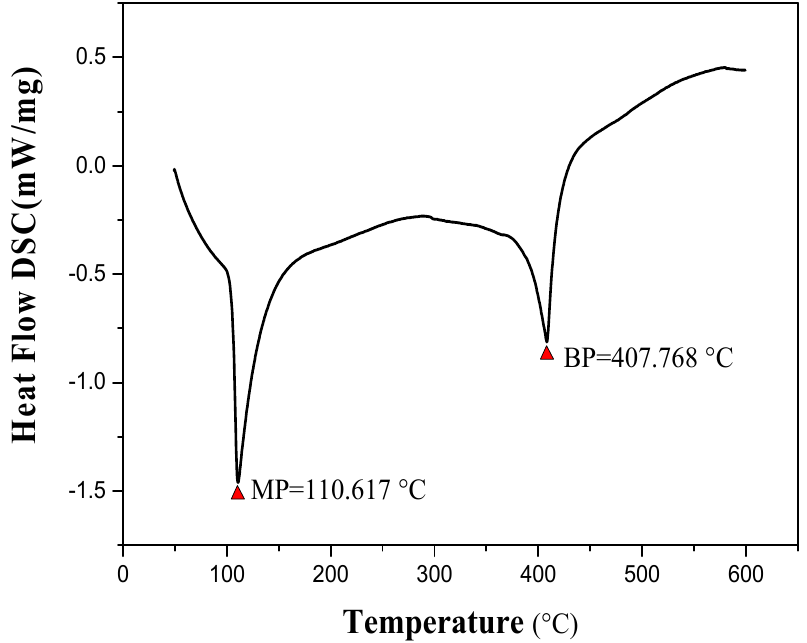
Figure 2. Differential thermal analysis of ABMP; the melting point is 110.617 °C, and the boiling point is 407.768 °C.